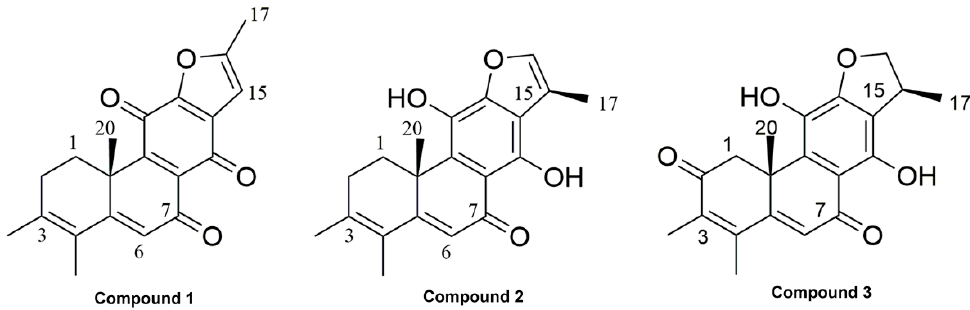
Figure 1. The structure of compounds 1 – 3 . (compound 1 , 12, 16-epoxy-17(15 → 16), 18(4 → 3)-diabeo-abieta-3, 5, 8, 12, 15-pentaene-7, 11, 14-trione; compound 2 , Ajuforrestin A; compound 3 , Ajudecumin A).